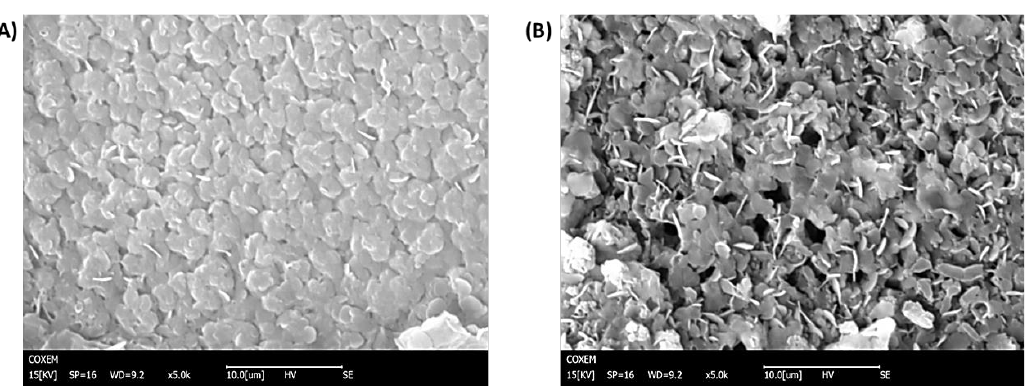
Figure 2. SEM images of ( A ) NIPPy/GO@Fe 3 O 4 ( B ) MIPPy/GO@Fe 3 O 4 .